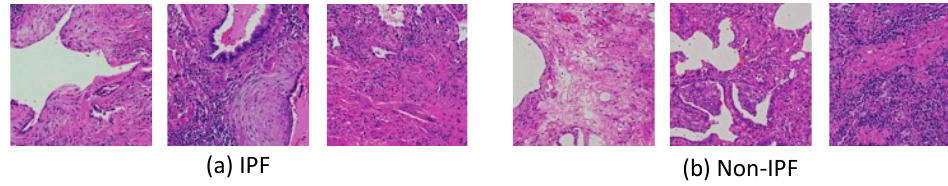
Figure 2. Preparation of patch images.